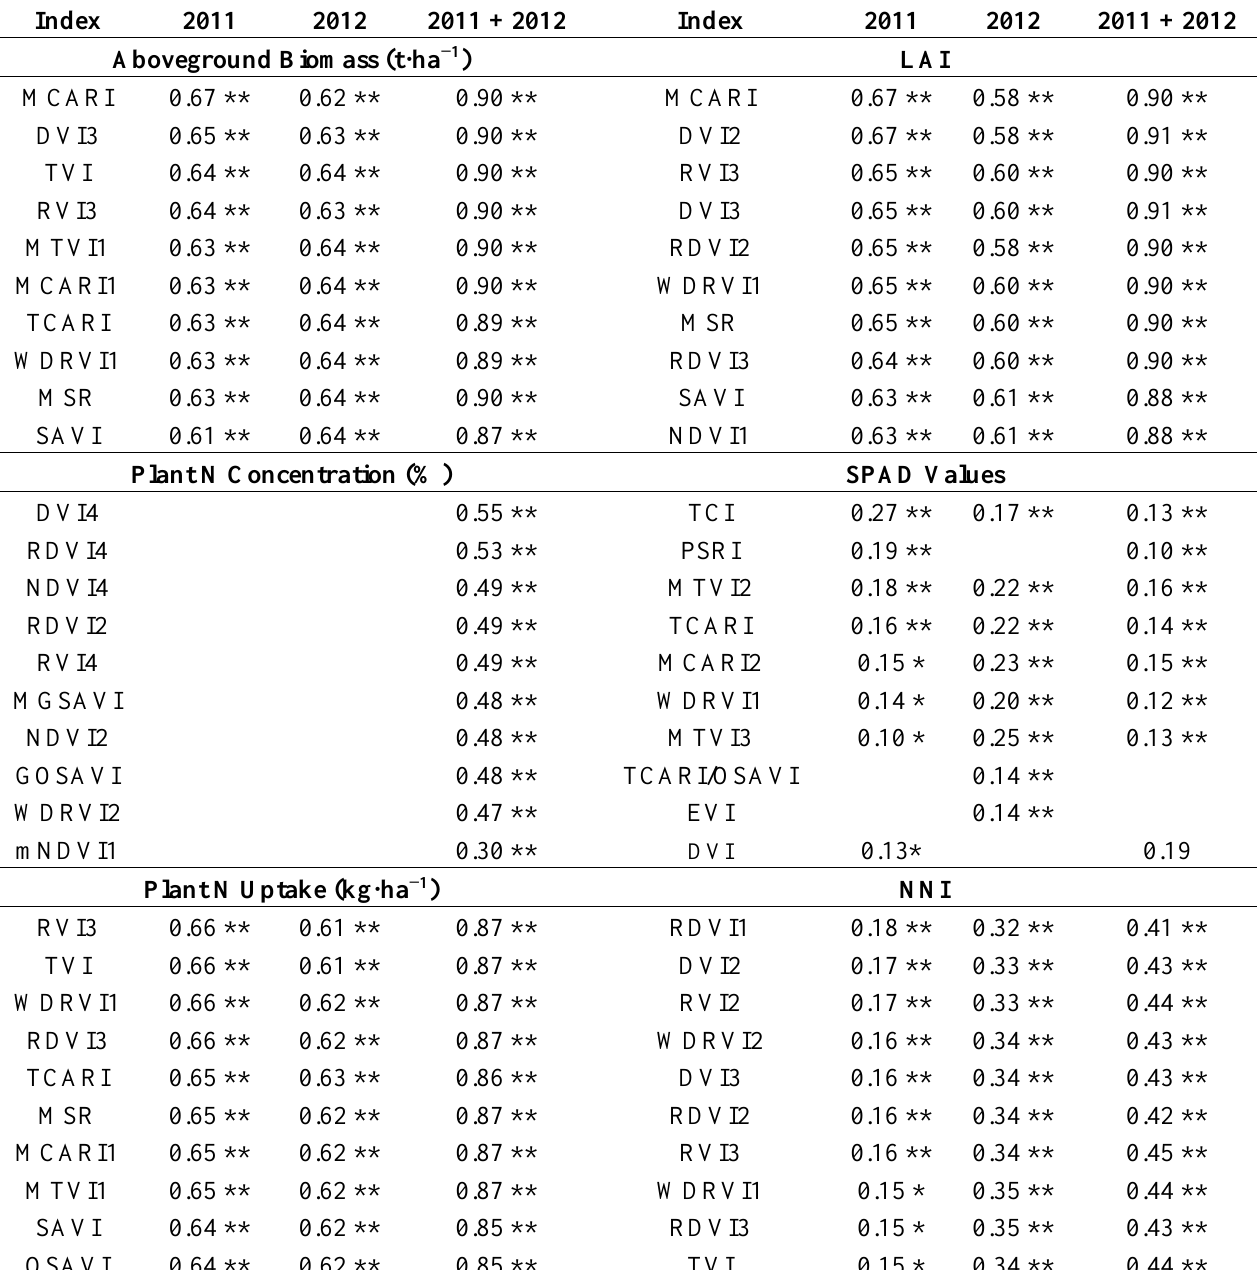
Table 5. The top 10 coefficients of determination (R 2 ) for the relationships between vegetation indices based on the FORMOSAT-2 satellite images and rice N status indicators in Heilongjiang Province, China, 2011–2012. Only significant R 2 values are